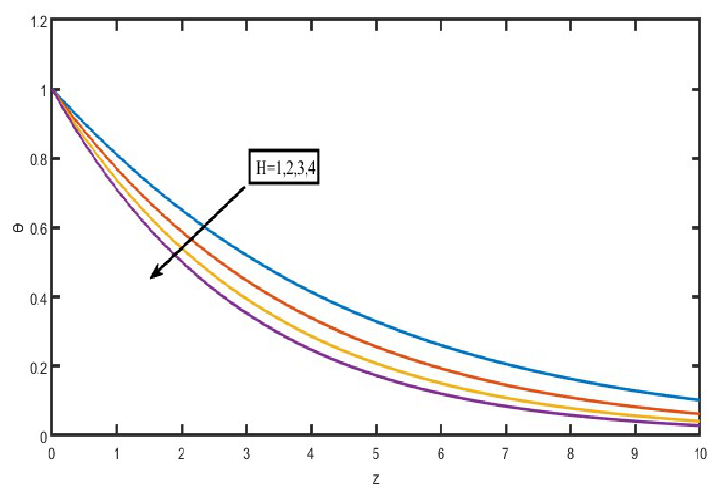
Figure 16. Temperature profiles for Heat absorption Parameter (H).